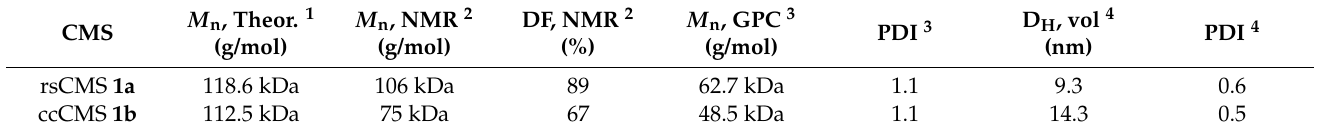
Table 1. Characterization data for redox and control CMS